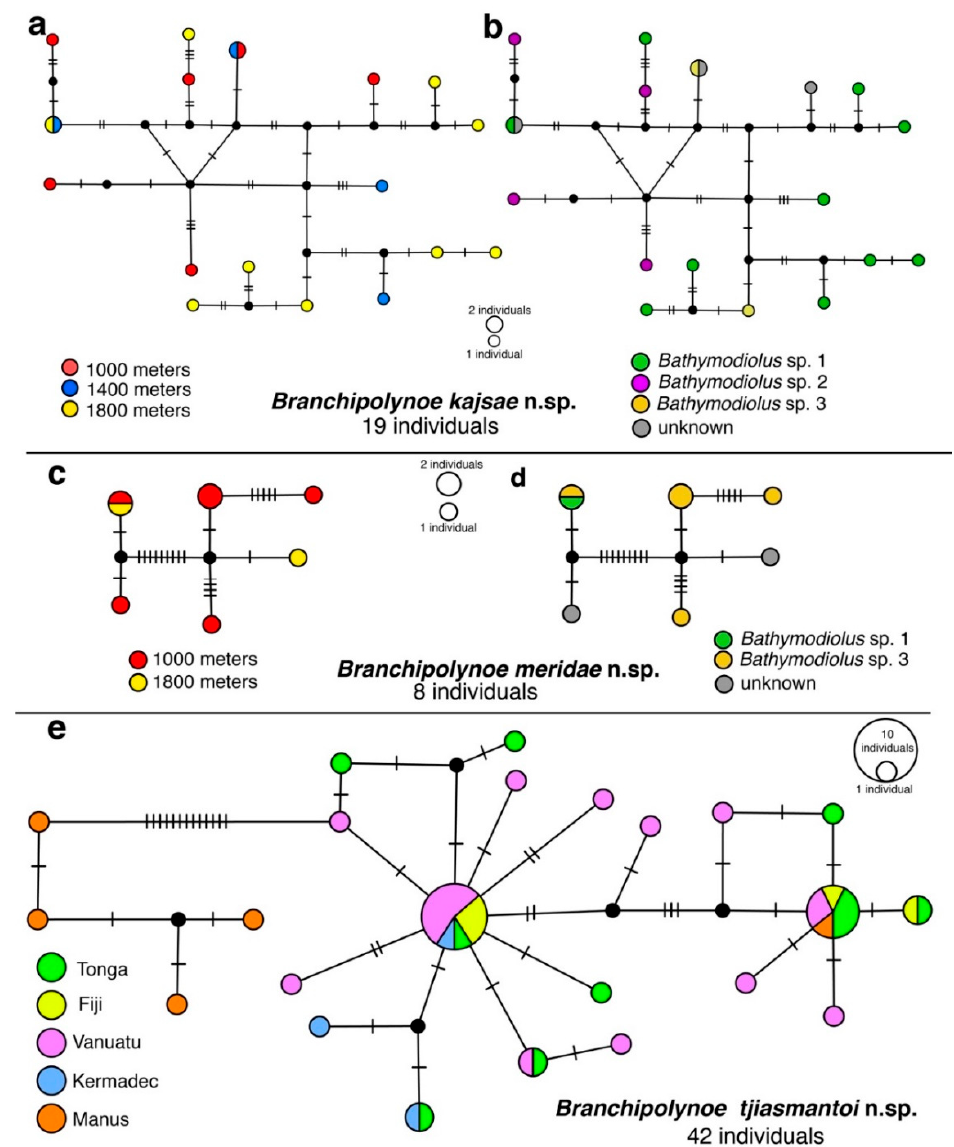
Figure 5. ( a ) COI haplotype network for 19 individuals of Branchipolynoe kajsae n. sp. with depth coding. ( b ) COI haplotype network for 19 individuals of Branchipolynoe kajsae n. sp. with host coding (where known). ( c ) COI haplotype network for 8 individuals of Branchipolynoe meridae n. sp. with depth coding. ( d ) COI haplotype network for 8 individuals of Branchipolynoe meridae n. sp. with host coding (where known). ( e ) COI haplotype network for 42 individuals of Branchipolynoe tjiasmantoi n. sp. with colors indicating geographic locality.